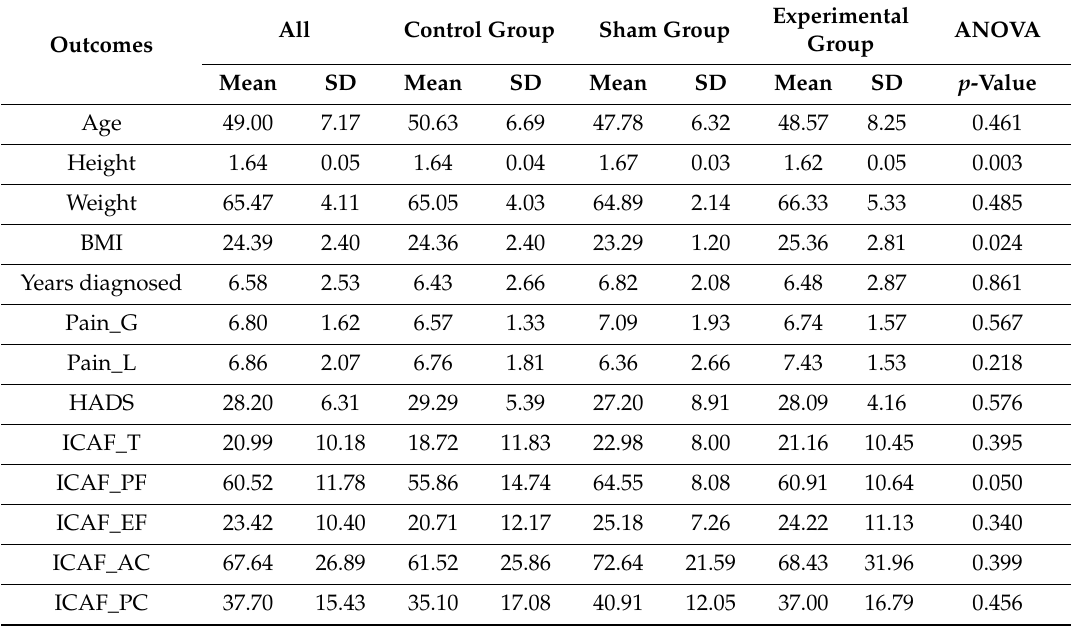
Table 1. Sociodemographic characteristics of the sample and baseline comparability of the groups.